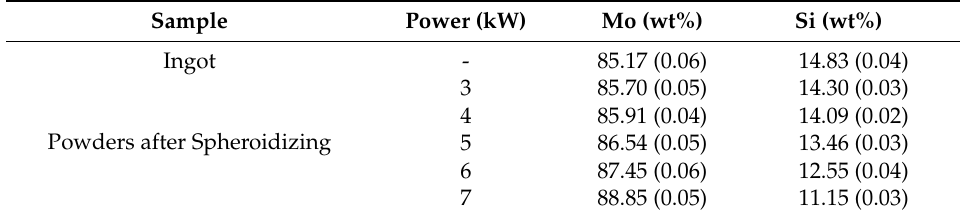
Table 1. Mo and Si concentrations (in wt%) of the ingot and powders after spheroidizing at plasma powers 3–7 kW. The values given in parenthesis refer to standard deviation.